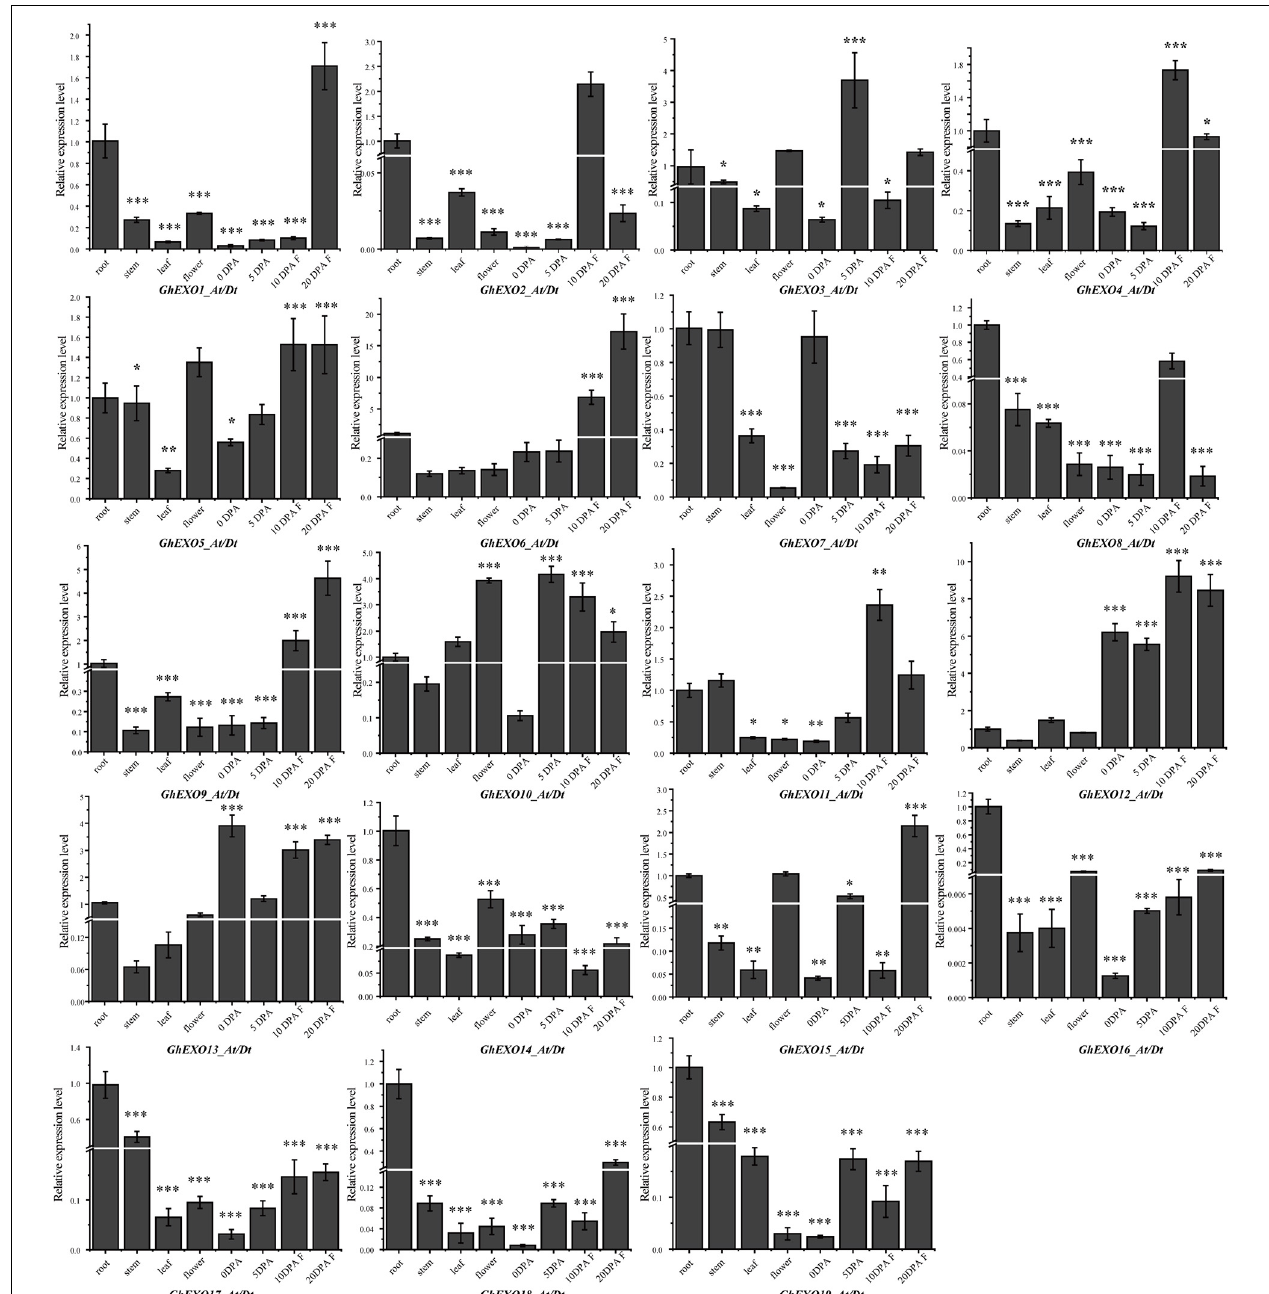
FIGURE 4 | Tissue specific expression pattern analysis of GhEXO genes. Expression of 19 GhEXO genes in four different tissues and in fibers at 0, 5, 10, and 20 days after anthesis (DPA) as determined by qRT-PCR. Error bars represent the standard deviations of three independent experiments. Significant differences were determined by Student’s t -test: ∗ p < 0.05, ∗∗ p < 0.01, ∗∗∗ p <